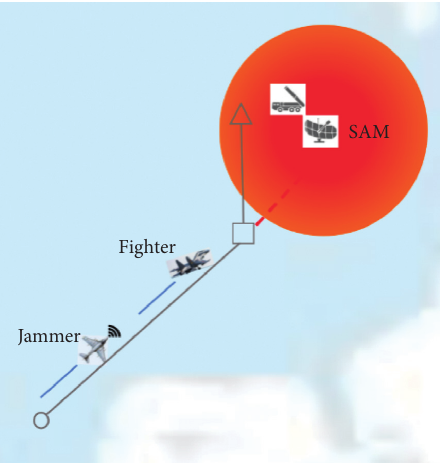
Figure 1: Schematic of a SEAD